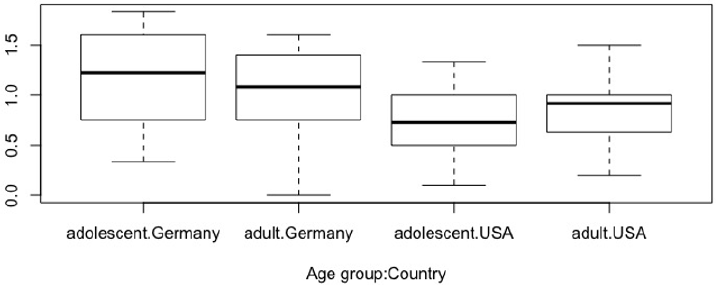
Figure 9. Current input in the HL (Greek) for each heritage group (USA, Germany) and age group (adults, adolescents).